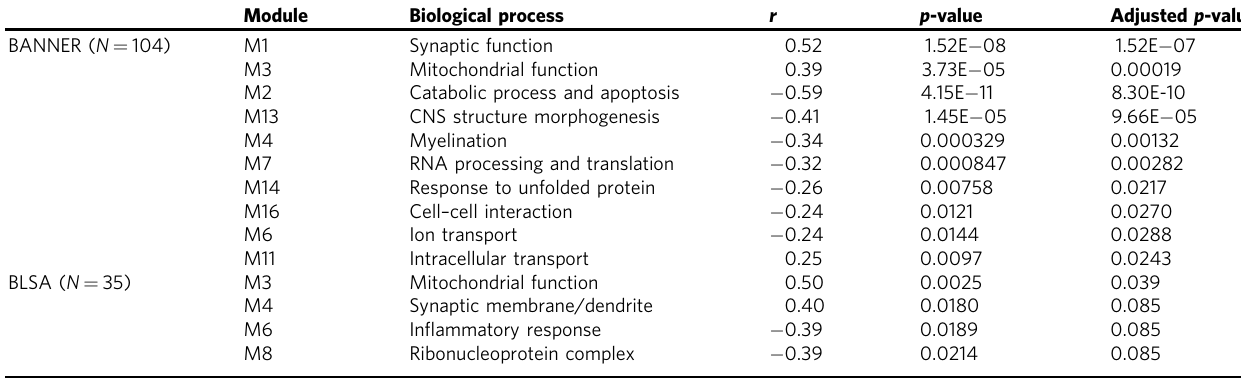
The table summarizes the Pearson correlation ( r ) between modules of co-expressed proteins and cognitive trajectory. The underlying data are available through the Synapse platform (https://www. synapse.org/#!Synapse:syn7170616 and https://www.synapse.org/#!Synapse:syn3606086) and Supplementary Data